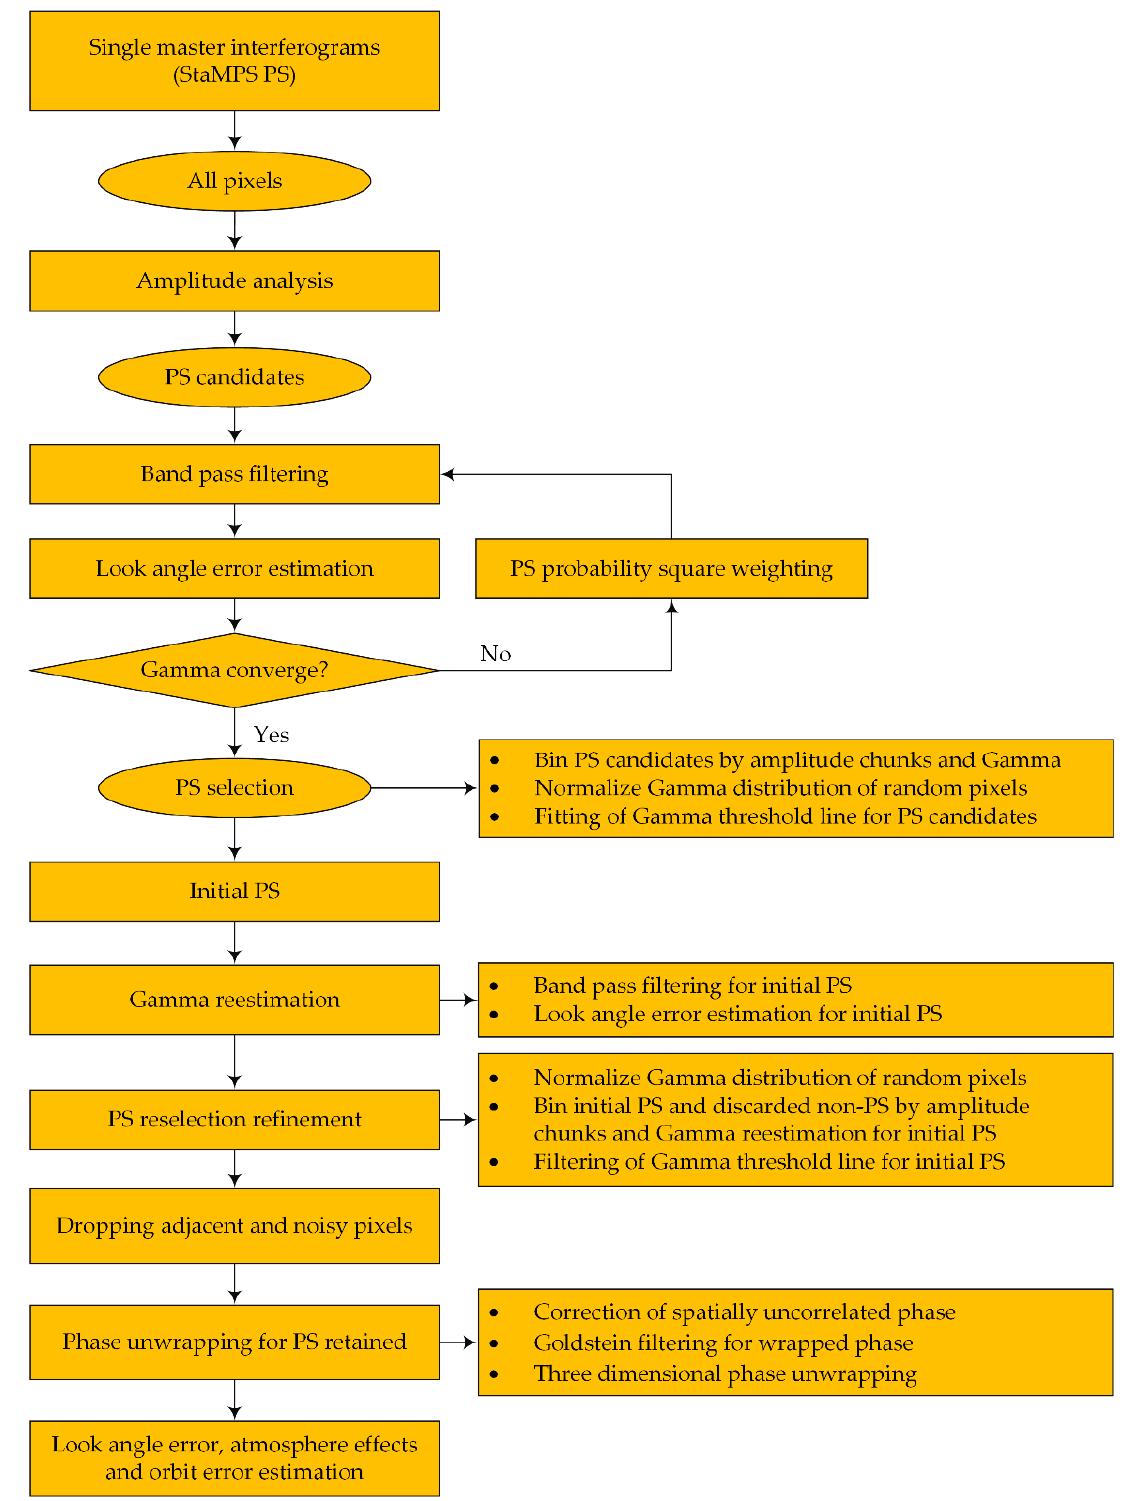
Figure 2. StaMPS technology flow